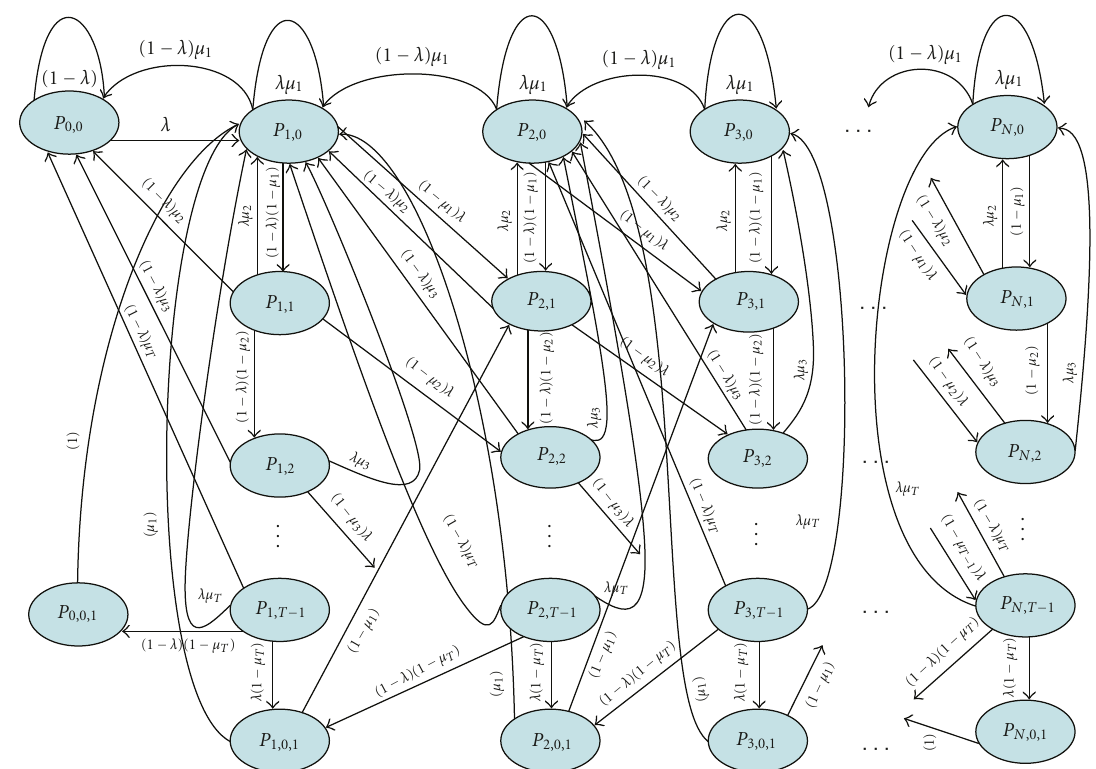
Figure 3: Probability state transitions of the router system with a bu ff er and a sequential